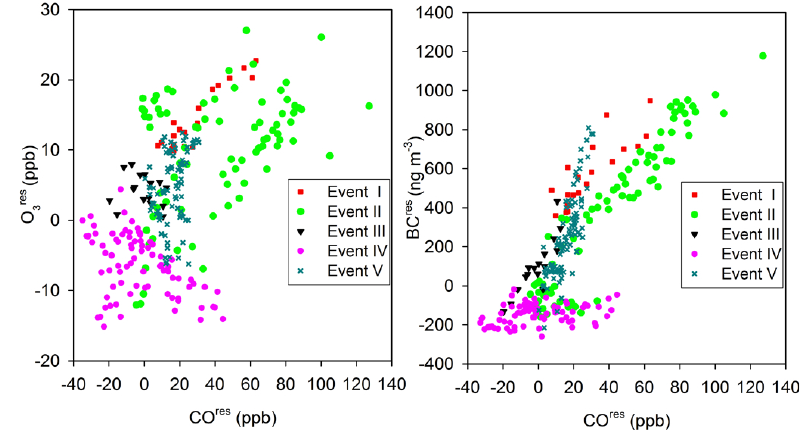
Fig. 4. Relationship between observed CO res , O res